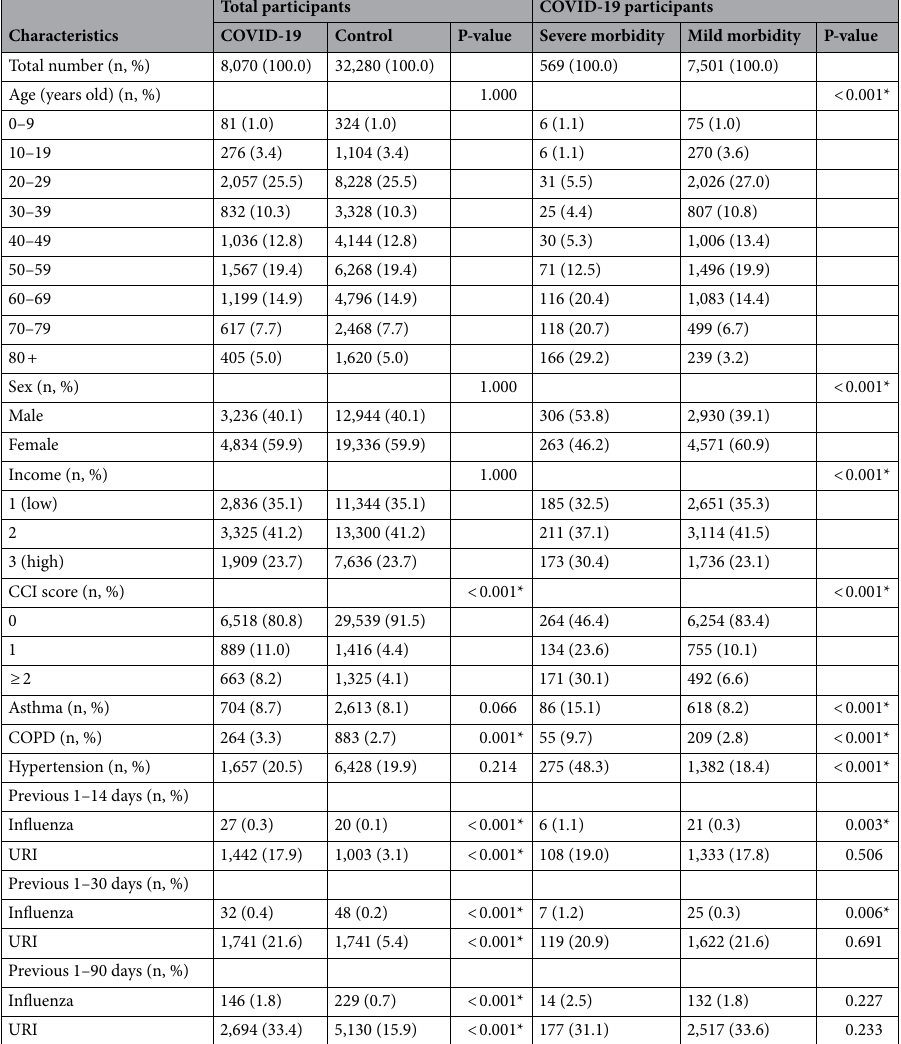
Table 1. General characteristics of participants. CCI, Charlson comorbidity index; COPD, chronic obstructive pulmonary disease; upper respiratory tract infection, URI; COVID-19, coronavirus disease 2019; SD, standard deviation. *Chi-square or Fisher’s exact test. Significance at P < 0.05. † Independent t test. Significance at P <